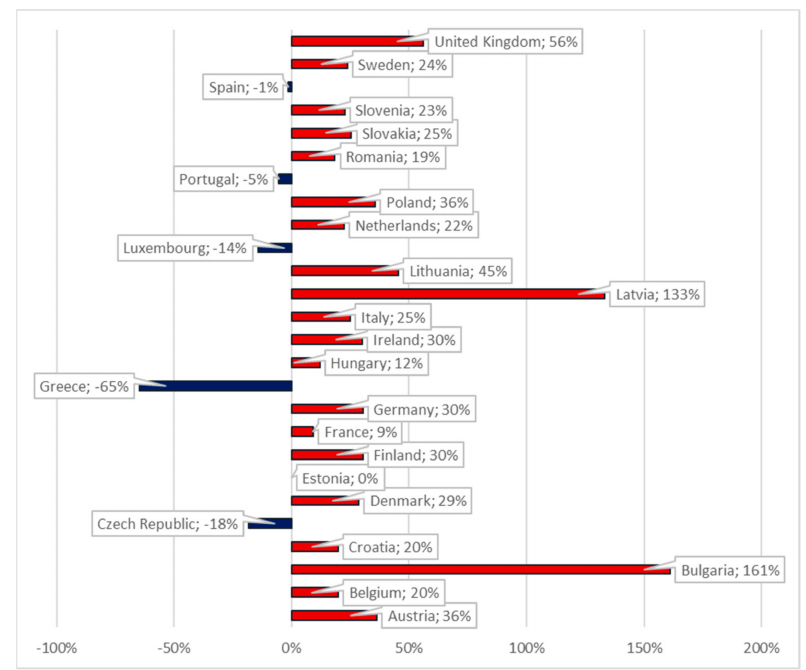
Figure 4. Expenditures of anti-cancer drug percentage change, 2010 and 2014 (26 EU countries).